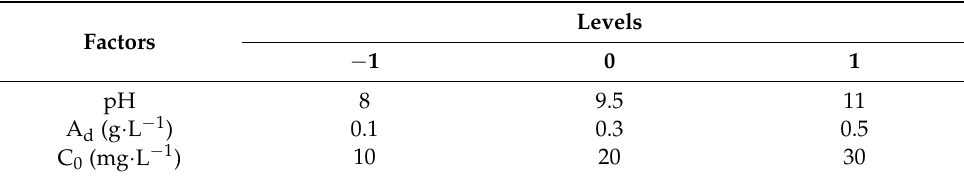
Table 1. Real and coded values of the experimental design. Levels Factors − 1 0 1 pH